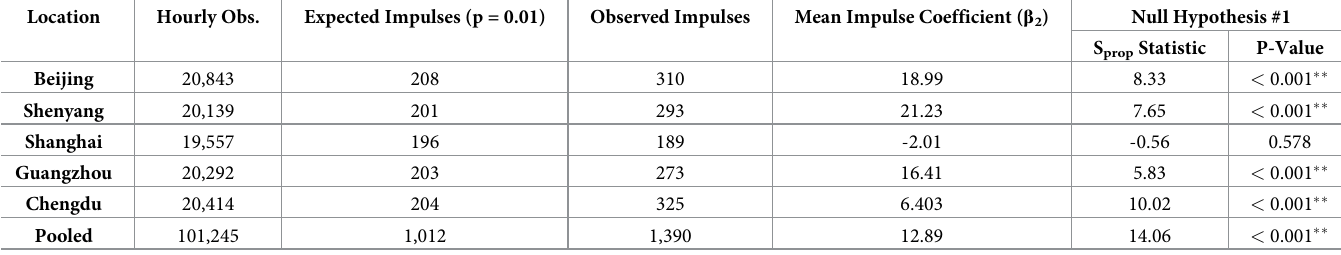
Table 1. Test of null hypothesis #1 for the five Chinese cities and pooled model. Location Hourly Obs.